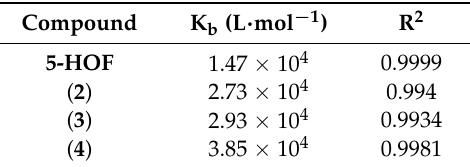
Figure 7. Absorption spectra of DNA in the absence and presence of increasing amounts of 5-HOF and complex ( 2 ). [DNA] = 15 µM; [compound] = 0; 5; 10; 15; 20; 25; 30 µM. Insert figures represent the plots of A 0 /(A − A 0 ) vs. 1/[Q]. The arrows show the absorption changes on increasing concentration of the tested compound. Table 4. Binding constants for 5-HOF and complexes ( 2 ), ( 3 ), ( 4 ), respectively and CT-DNA interaction systems.